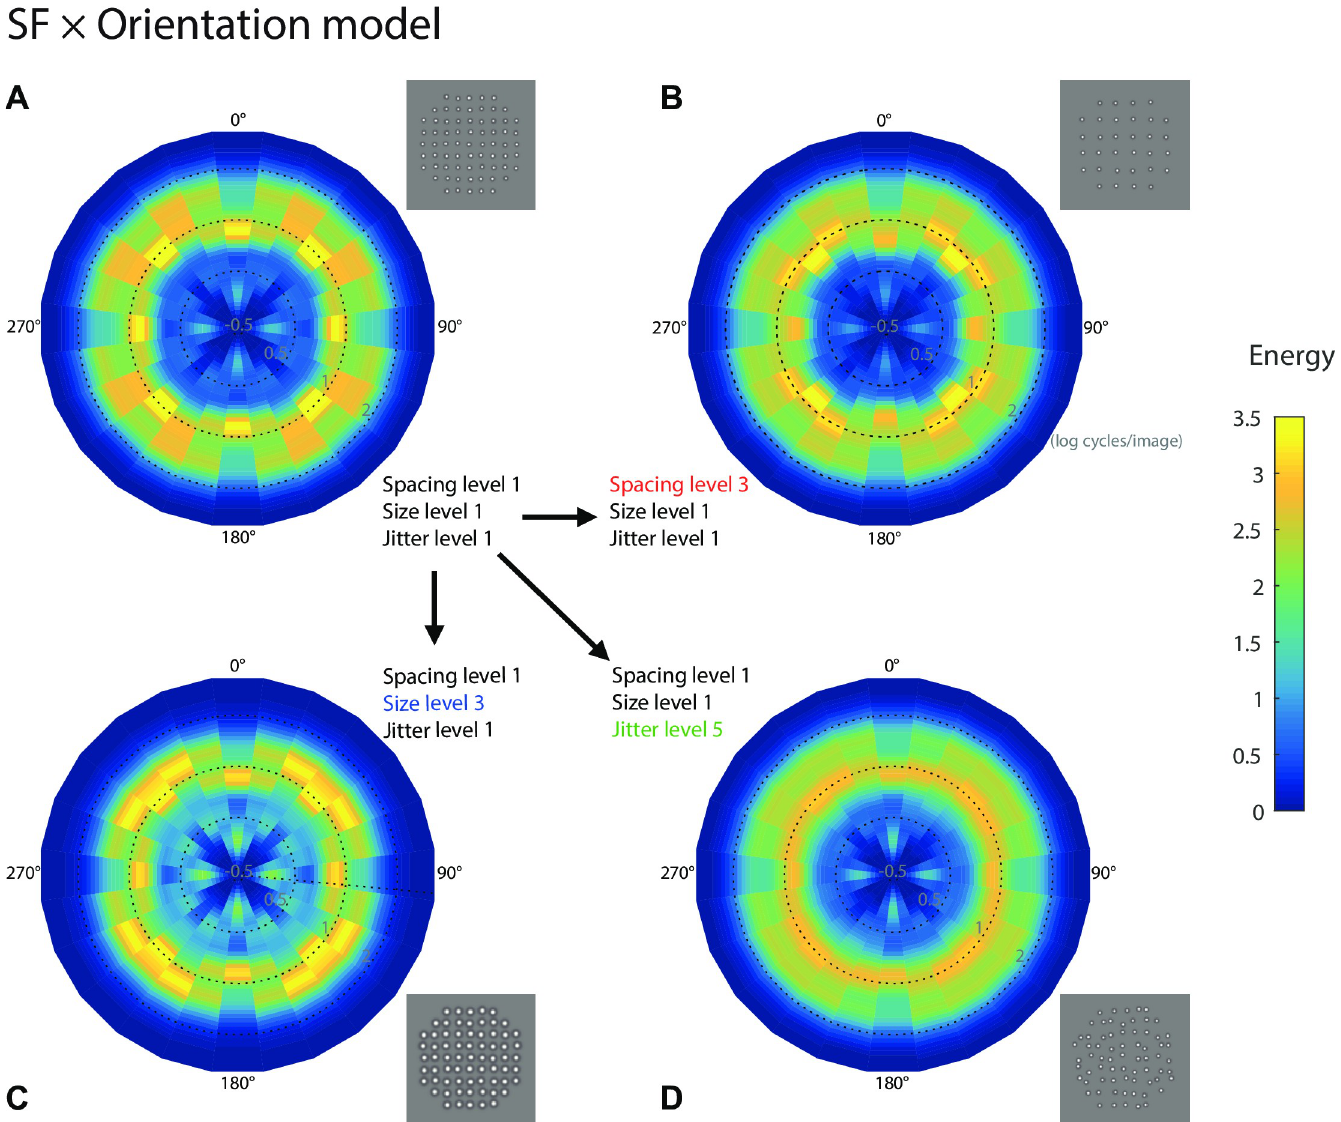
Fig 9. Gabor wavelet analysis results for the SF × orientation distribution model. The same SF analysis as in Fig 8 was performed, except the SF distributions were analyzed separately for each of the 12 orientations, and then the standard deviations of the distribution parameters across orientations were calculated [16]. The SF distributions are represented as polar image plots of energy (RMS responses) as a joint function of spatial frequency (distance from center, as scaled by circular dotted lines for three SF levels 0.5, 1 and 2 log cycles/image) and orientation (polar angle) for four selected experimental conditions. In (A) we show a standard reference condition for element spacing, size and jitter all at level 1, which can be compared to element spacing change (B), element size change (C) and jitter change (D). The results show that jitter spreads out the energy across orientations much more than spacing or size.